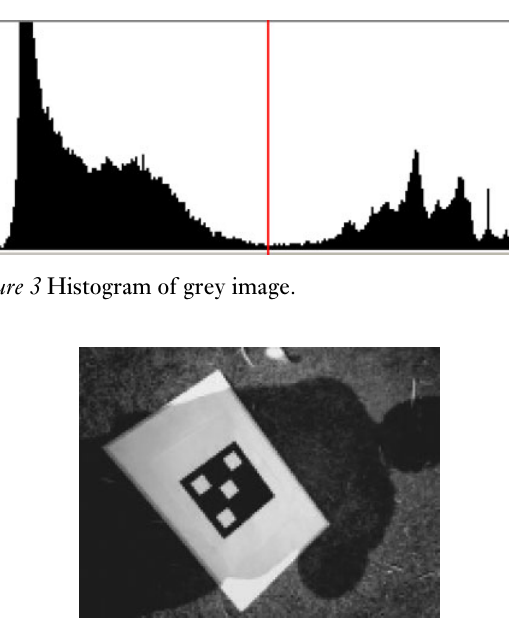
Figure 4 Sample grey image.